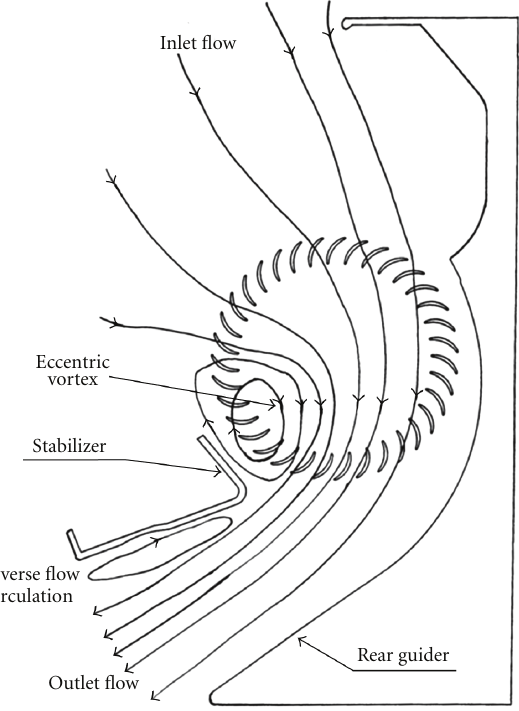
Figure 1: Typical flow pattern in a cross-flow fan.